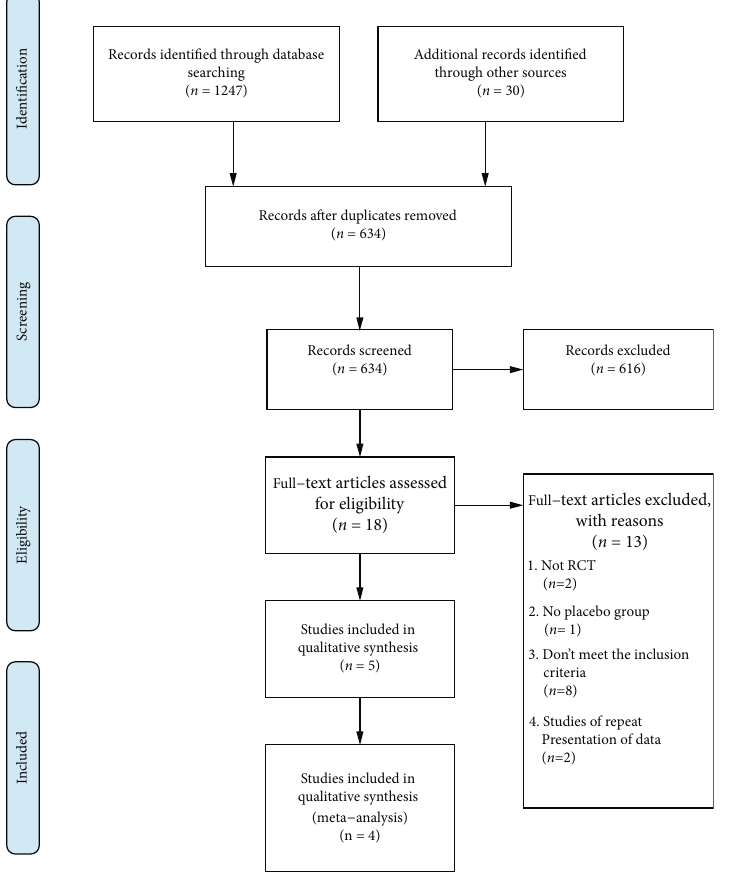
Figure 1: Flow chart of the literature